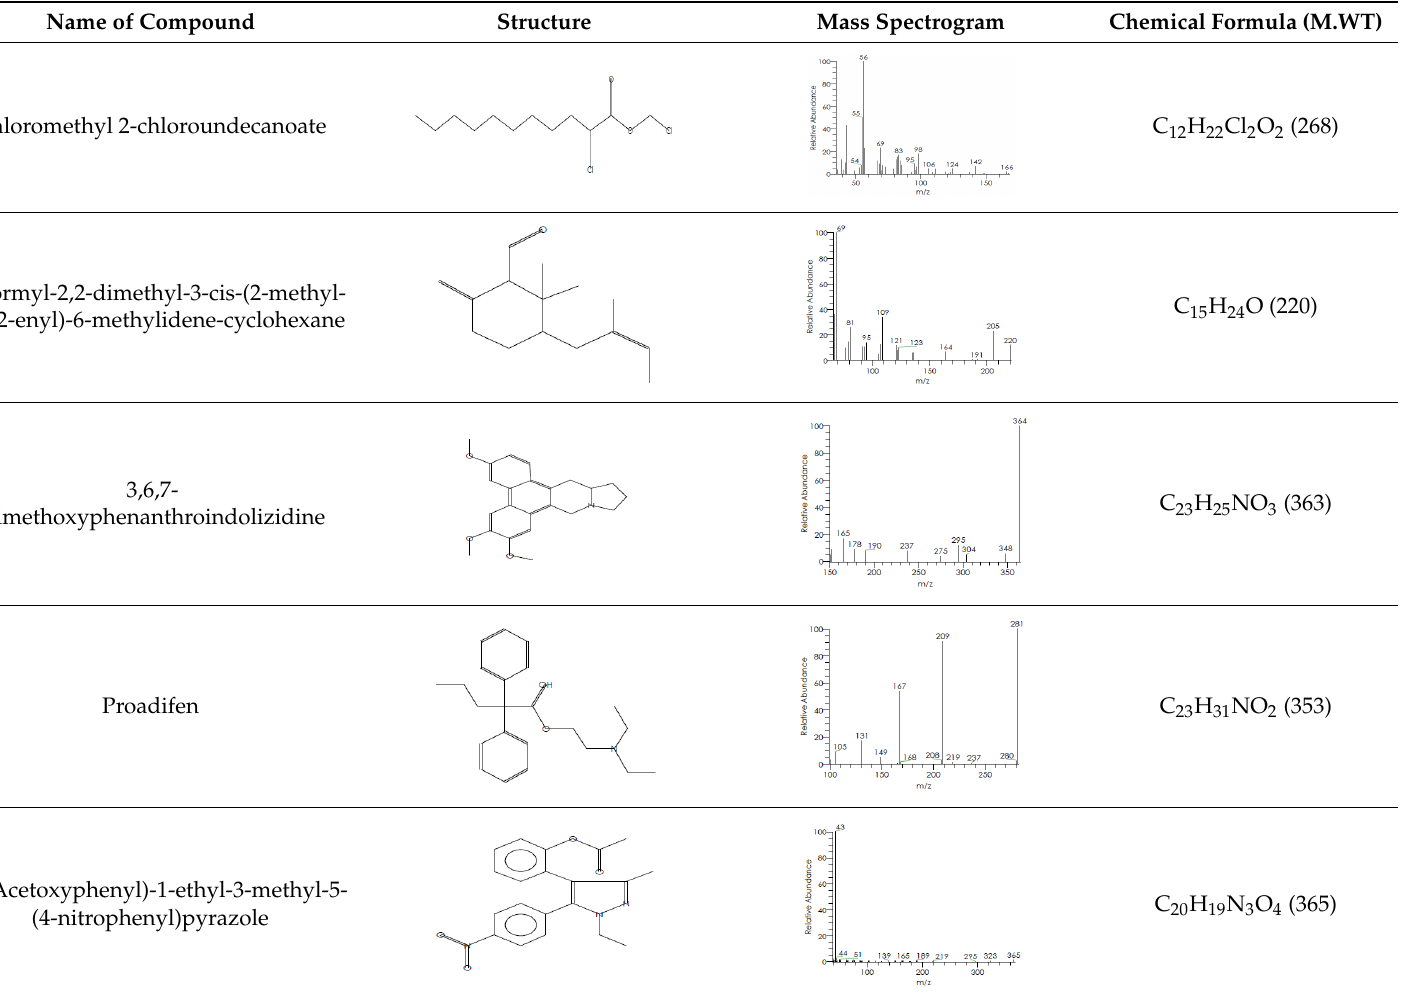
Table 1. GC-MS of ethanol extract of rhizome of Euphorbia wallichii (REEW) showing various phytochemicals. P.N RT Peak Area Peak Height Name of Compound Structure Mass Spectrogram